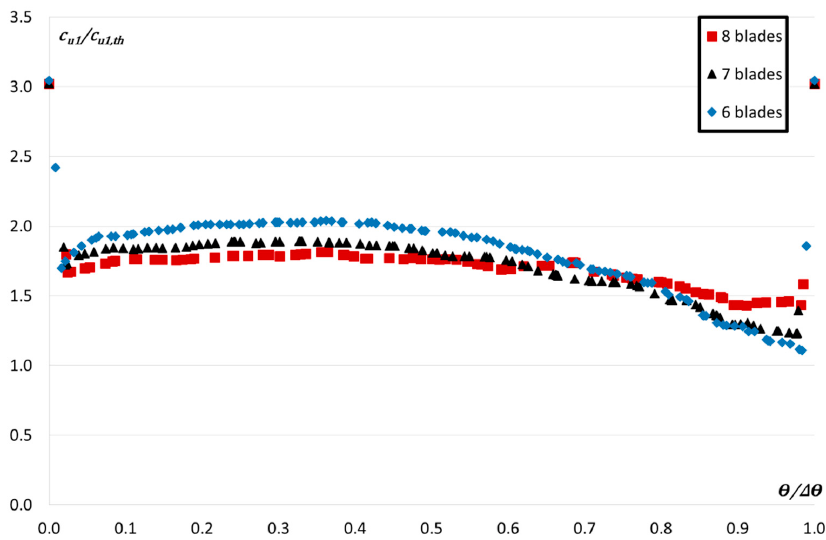
Figure 8. Absolute tangential velocity calculated via CFD ( c u 1 ) over the blade congruent value for the three geometries ( c u 1, th